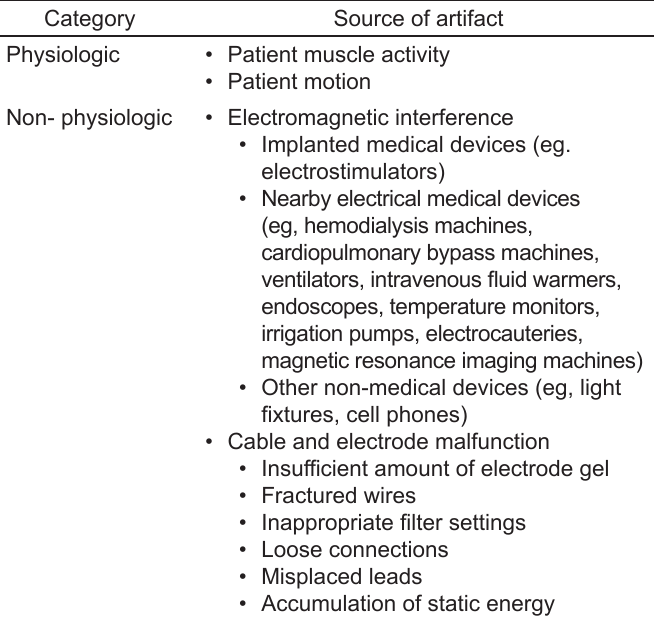
Table. Categories and sources of electrocardiogram